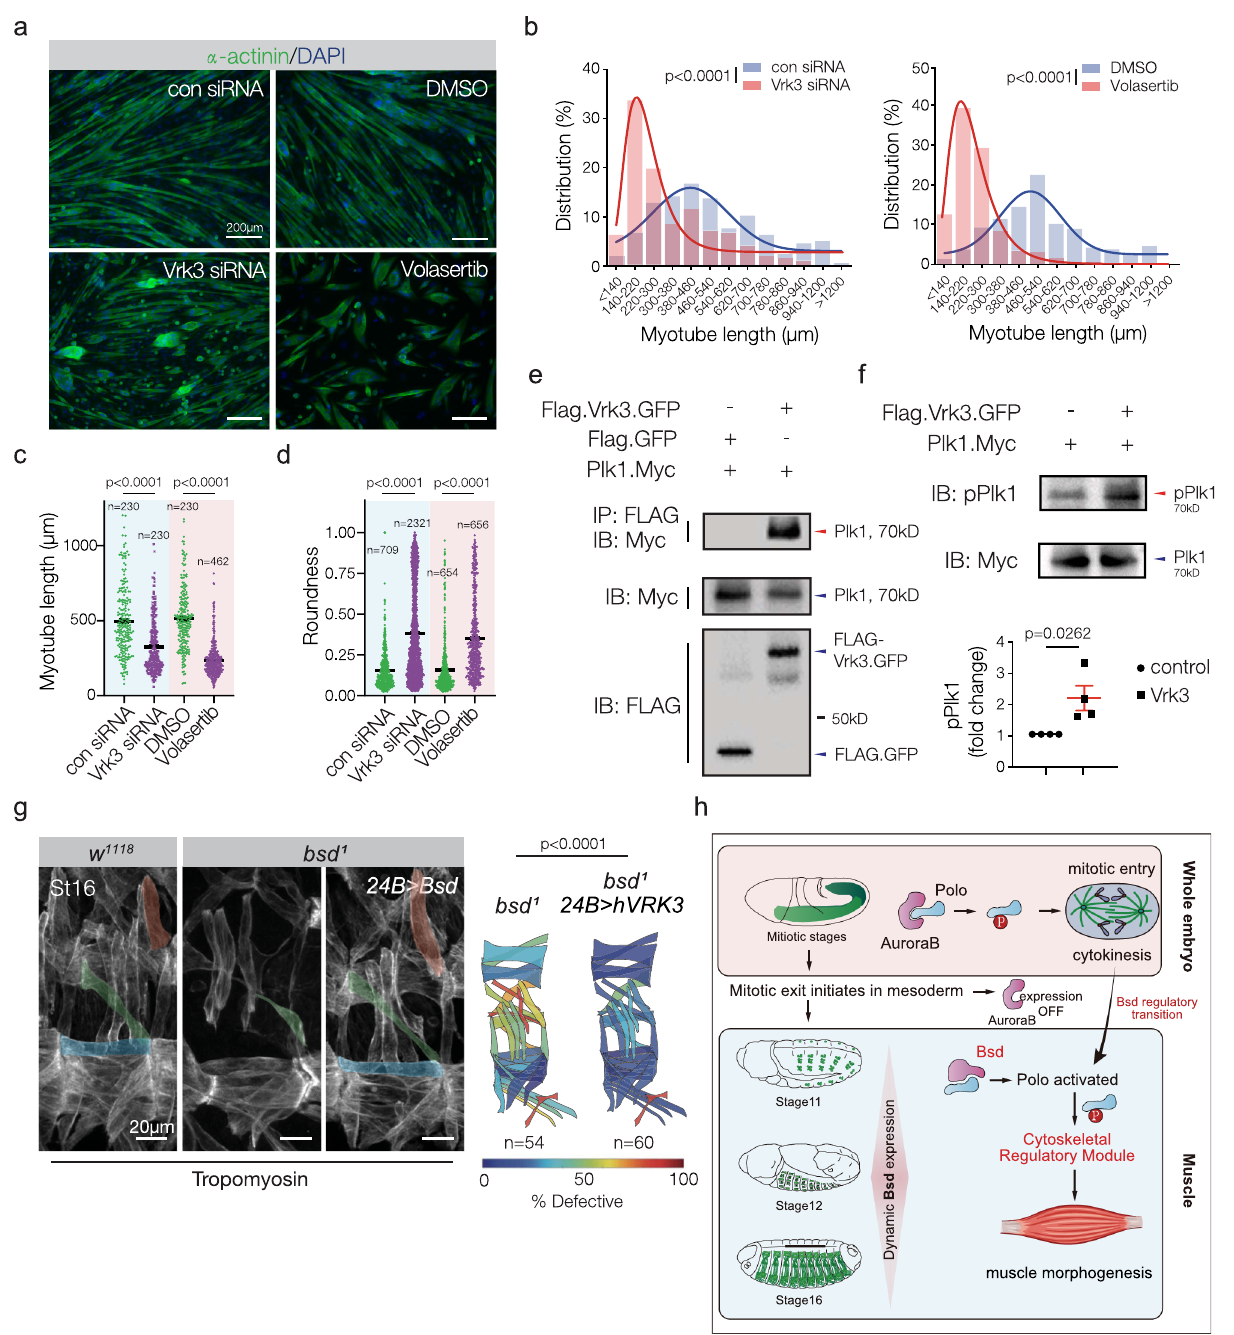
Fig. 7 The Bsd orthologue Vrk3 is required for myotube elongation. a C2C12 cells treated with siRNAs against murine Vrk3 or with an inhibitor of Plk1 (Volasterib, 100 nM). Cells were fi xed after 7 days in differentiation media, and labeled for α -actinin (green) to detect differentiated myotubes. Vrk3 knockdown and Volasterib treated myotubes were shorter than controls and were often rounded. b Myotube length distribution. Solid lines show the Gaussian distribution fi t curve (blue) and skew distribution fi t curve (red). Vrk3 RNAi and Volasterib treated myotubes were shorter than controls. For each group, n = 230. c Quanti fi cation of cumulative myotube length. d Myotube roundness scores. Vrk3 RNAi and Volasterib treated myotubes showed a higher roundness score, indicating increased circularity. e Immunoprecipitation of HEK293 cell lysates showed a physical interaction between Vrk3 and Plk1. f Western blot of HEK293 cell lysates transfected with Vrk3 and Plk1. Vrk3 promoted Plk1 phosphorylation at Thr210. For each group, n = 3. g Control ( w 1118 ), bsd 1 UAS.VRK3 , and bsd 1 24B.Gal4 > VRK3 embryos labeled for Tropomyosin. DT1, LO1, and VL1 muscles are pseudocolored orange, green, and violet. bsd 1 embryos that expressed human VRK3 in the mesoderm showed improved muscle morphology ( h ) Model showing Polo activation transitions from AurB in mitotic tissues to Bsd in post-mitotic tissues. Polo controls cytoskeletal regulatory module to direct cytokinesis and myotube guidance. Signi fi cance was determined by unpaired Student ’ s t test ( b , d ), Mann – Whitney U test ( c ) and Fisher ’ s exact test ( g ). Error bars represent